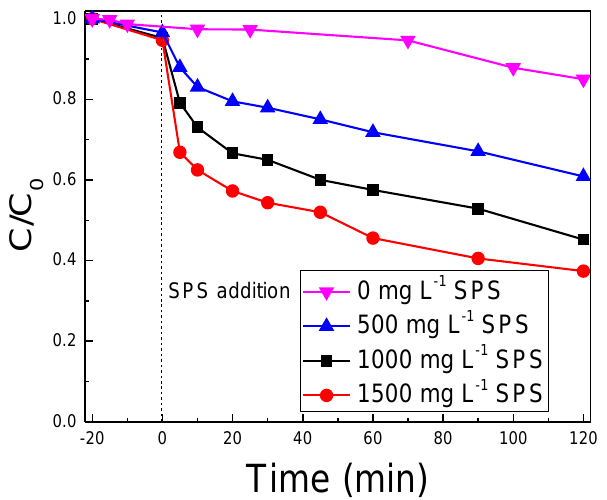
Figure 4. Effect of SPS concentration on 500 µ g L − 1 SMX degradation with 100 mg L − 1 RHB700 in UPW and inherent pH.